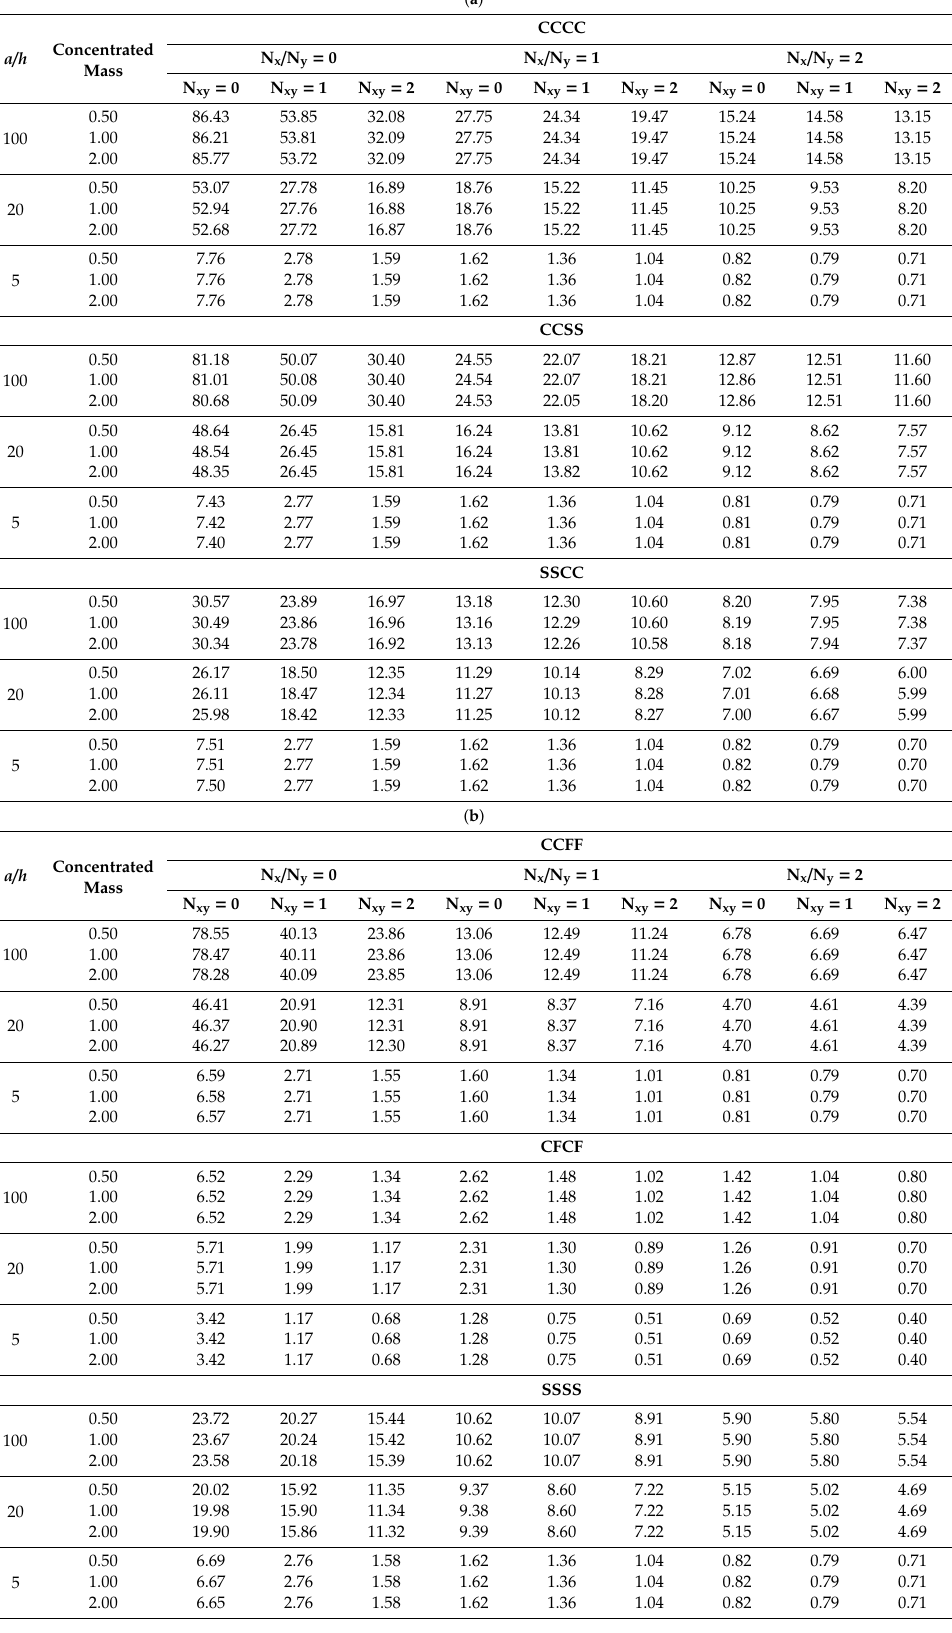
Table 6. ( a ) Non-dimensional buckling load λ = ( λ b 2 /E 2 h 3 ) for a bi-axial buckling of a composite plate having lamination scheme A and additional mass; ( b ) Non-dimensional buckling load λ = ( λ b 2 /E 2 h 3 ) for a bi-axial buckling of a composite plate having lamination scheme A and additional